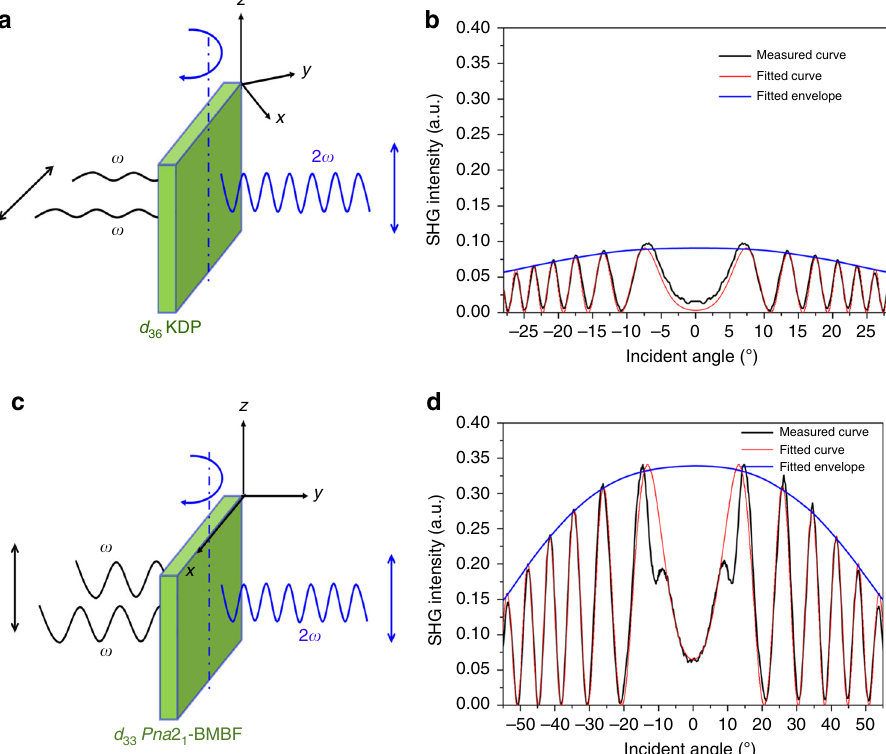
Fig. 6 Maker fringe measurement for Pna 2 1 -Ba 3 Mg 3 (BO 3 ) 3 F 3 crystal. a , c The orientations of as-grown crystal plates for measuring the NLO coef fi cients. b , d The measured and calculated Maker fringe data as well as fi tted envelope for d 36 of KH 2 PO 4 (KDP) and d 33 of Pna 2 1 -Ba 3 Mg 3 (BO 3 ) 3 F 3 . The data were fi tted according to the Maker fringe theory and the detailed fi tting procedure is available in the Methods section